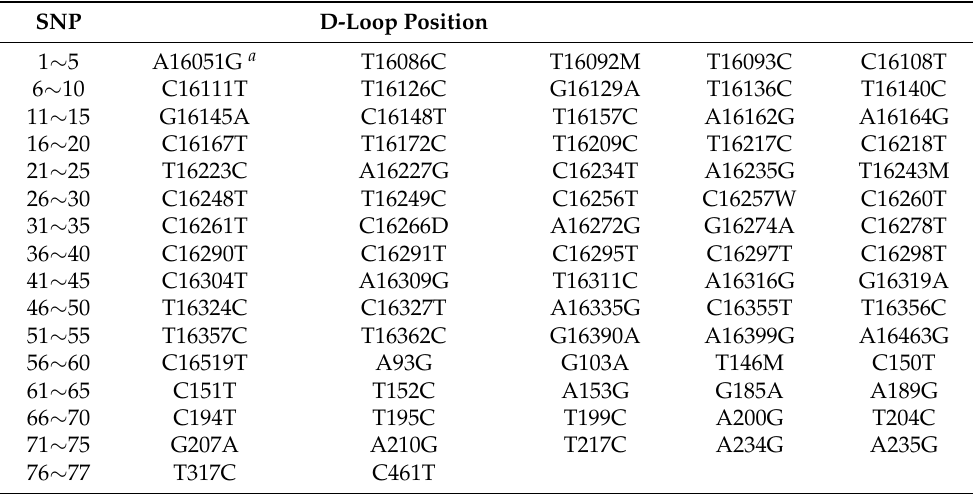
Table 6. The top ten highest HISC CR -valued two-order SNPs were used as ten candidate combinations. Rank Combination HSIC CR 1 41,